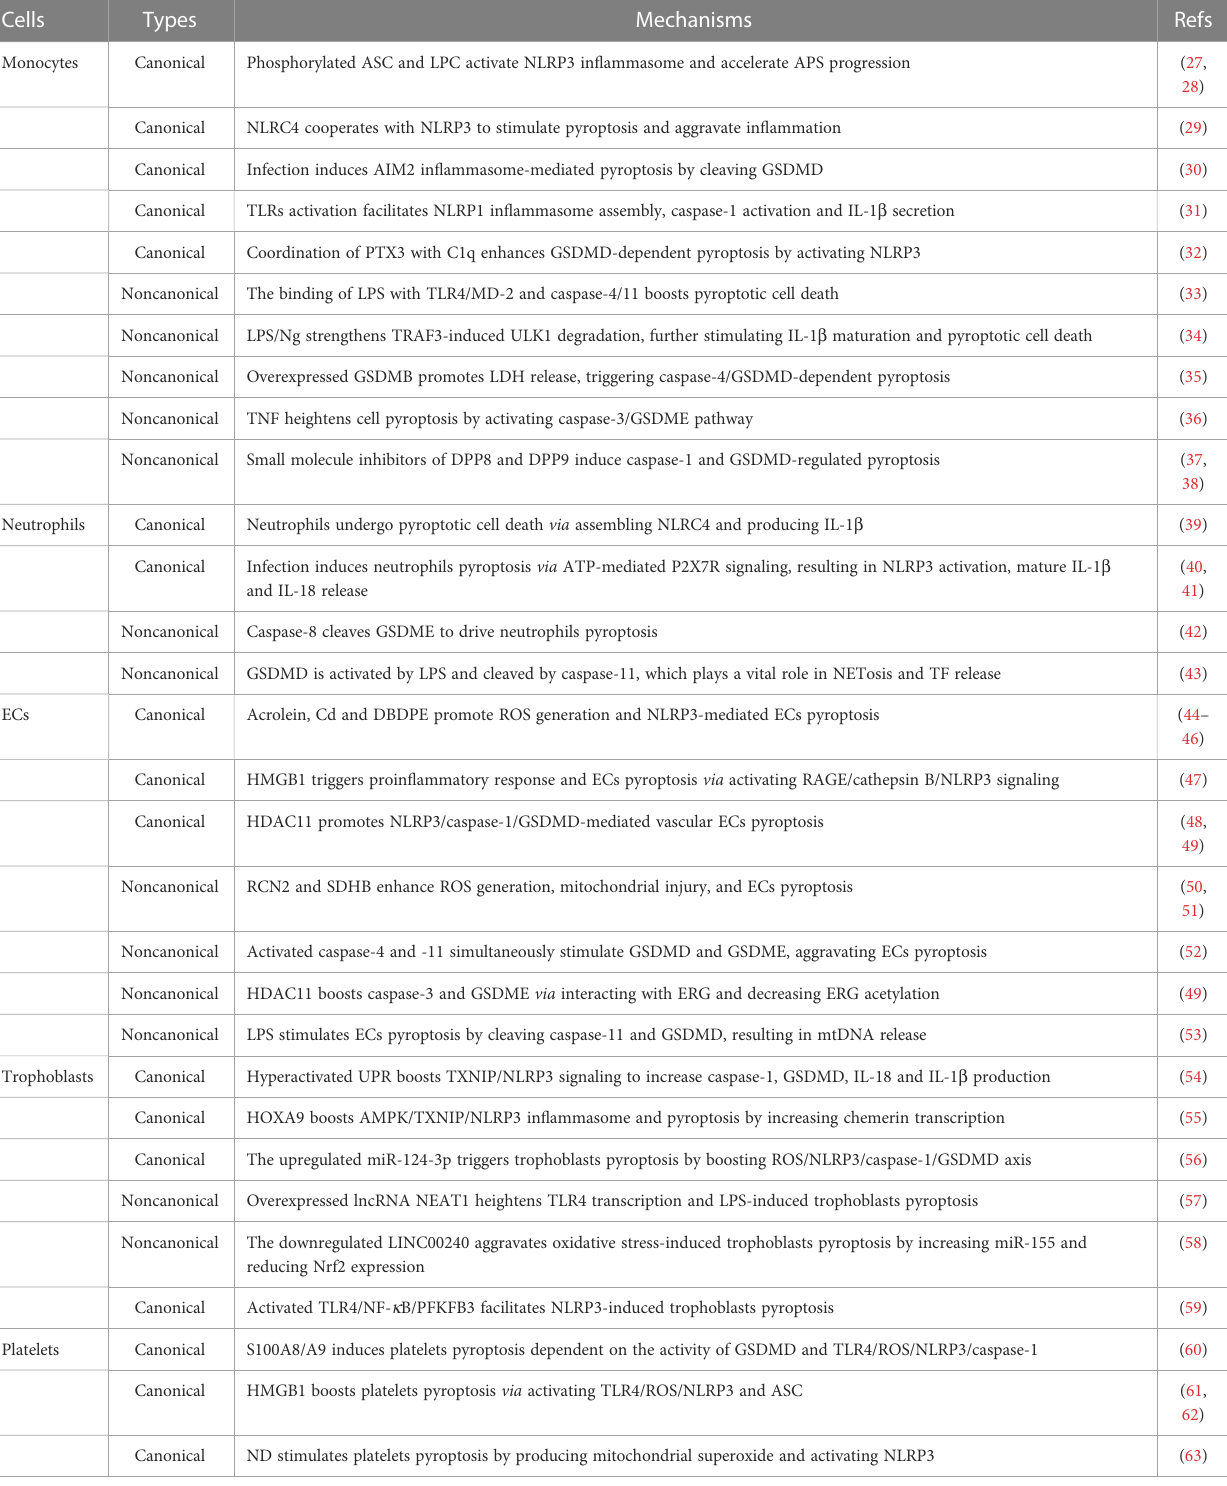
TABLE 1 The pyroptosis-mediated pathological effects in APS